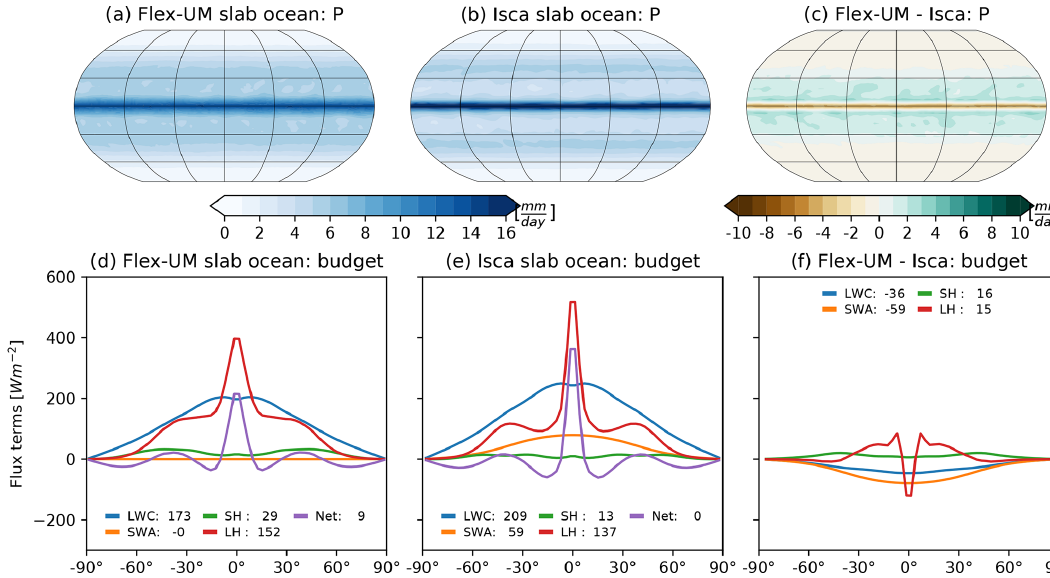
Figure 5. As in Fig. 3 but for precipitation ( P in mmd − 1 , a, b, c ) and the atmospheric energy budget (Wm − 2 , d, e, f